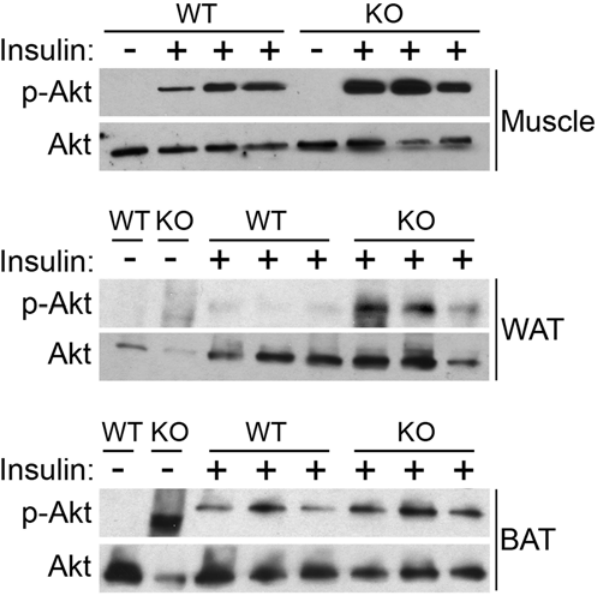
Figure 4. Insulin-stimulated activation of Akt by Western blot. In vivo total Akt and phospho-Akt in gastrocnemius muscle, WAT, and BAT from Mstn + / + and Mstn 2 / 2 mice with or without insulin stimulation. Each lane contains protein from a different animal.